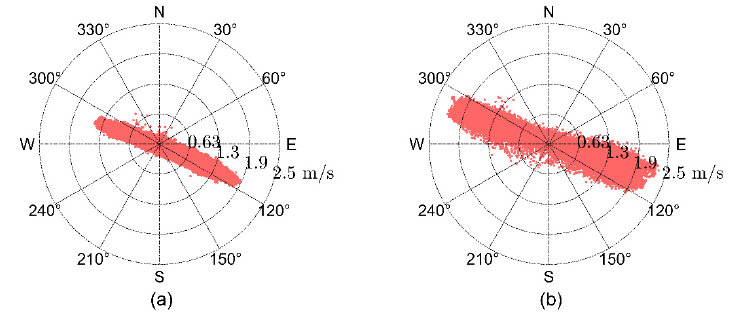
Figure 4. Current speed and direction from instruments ( a ) CWTb1 and ( b ) CW4.